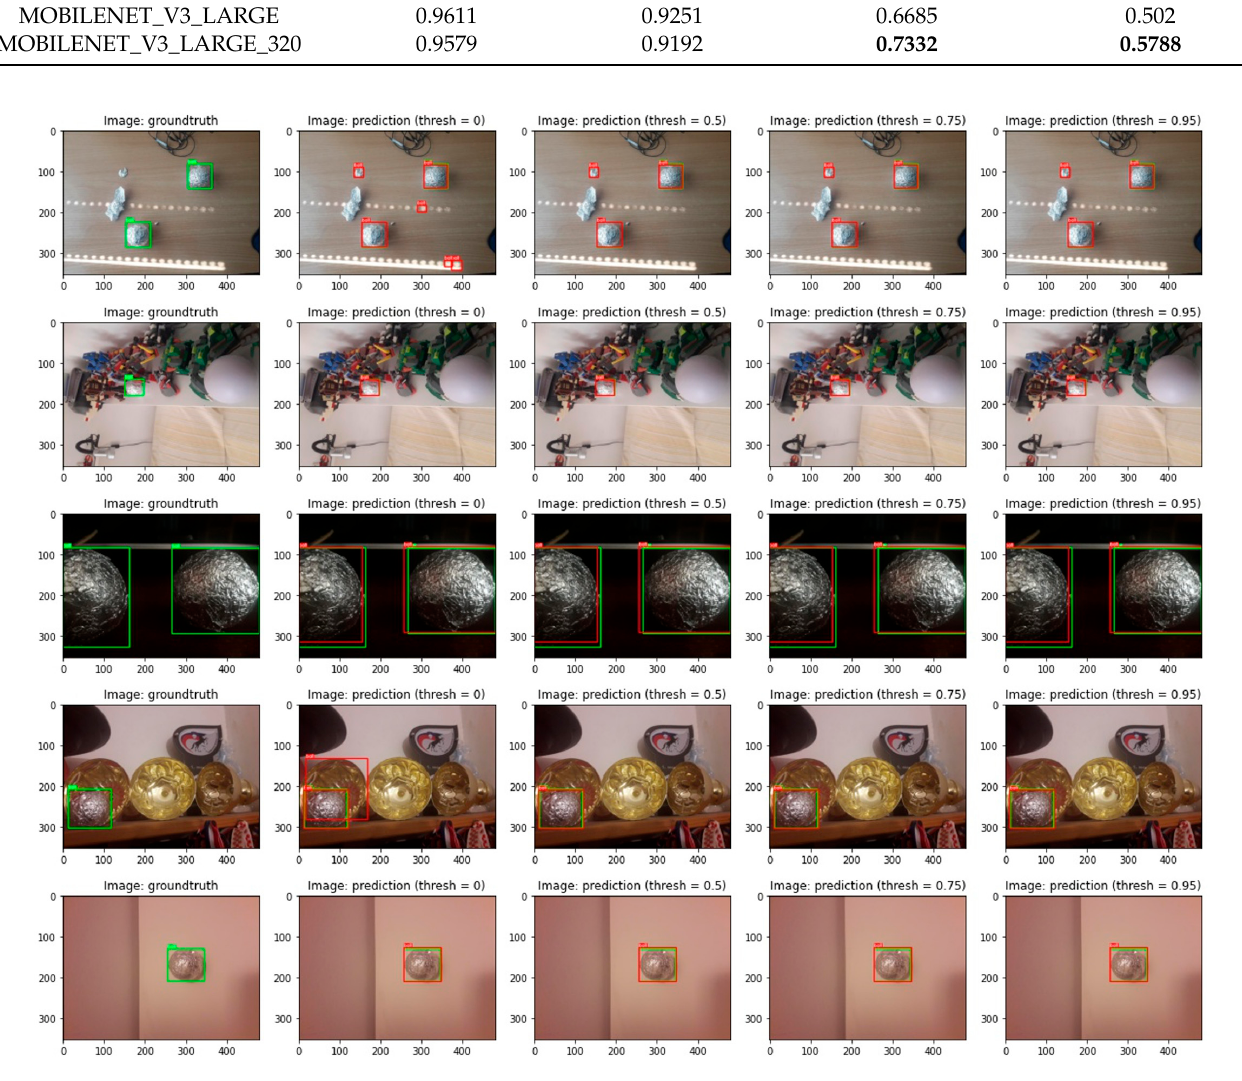
Figure 8. Object detection MobileNet_V3_Large model’s predictions with different probability thresholds. From left to right: original input image, prediction with 0% threshold, prediction with 50% threshold, prediction with 75% threshold and prediction with 95% threshold. Green bounding boxes represent annotated ground truths and the red ones predicted